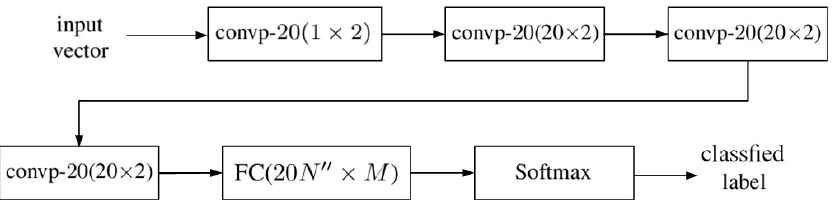
Figure 1. The 1D input vector retrieved from a hyperspectral image (HSI) cube.